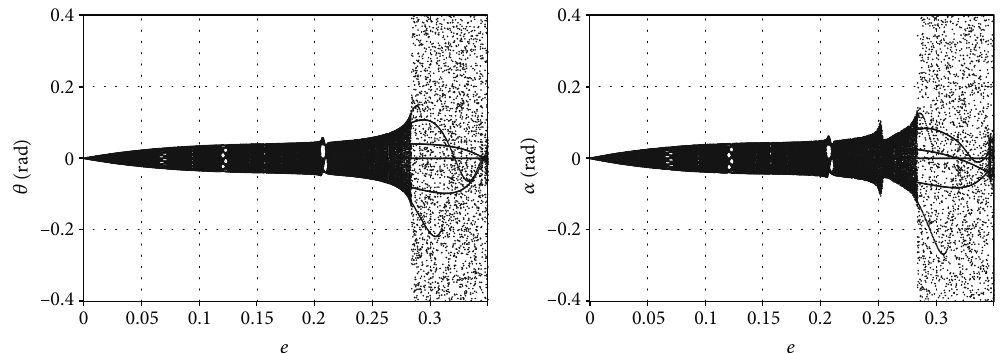
Figure 3: Bifurcation diagrams changing with orbital eccentricity e under nonresonance.